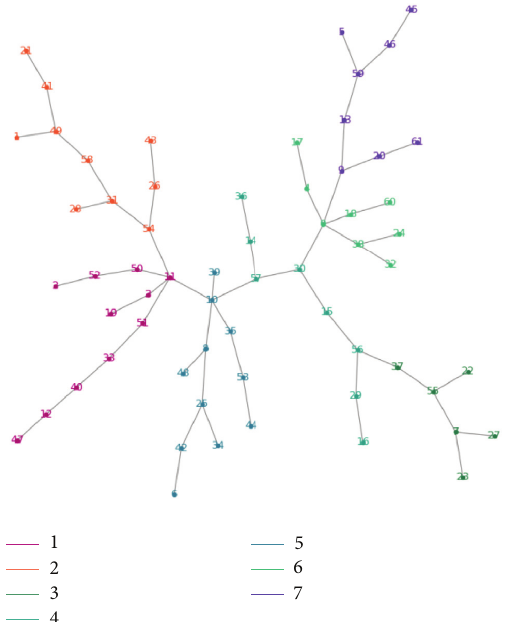
Figure 10: The community of energy stock price jump from April 2018 to October 2018. Table 8: Communities with the strongest correlation coefficient at different time periods. Period Stock code Averagecorrelation